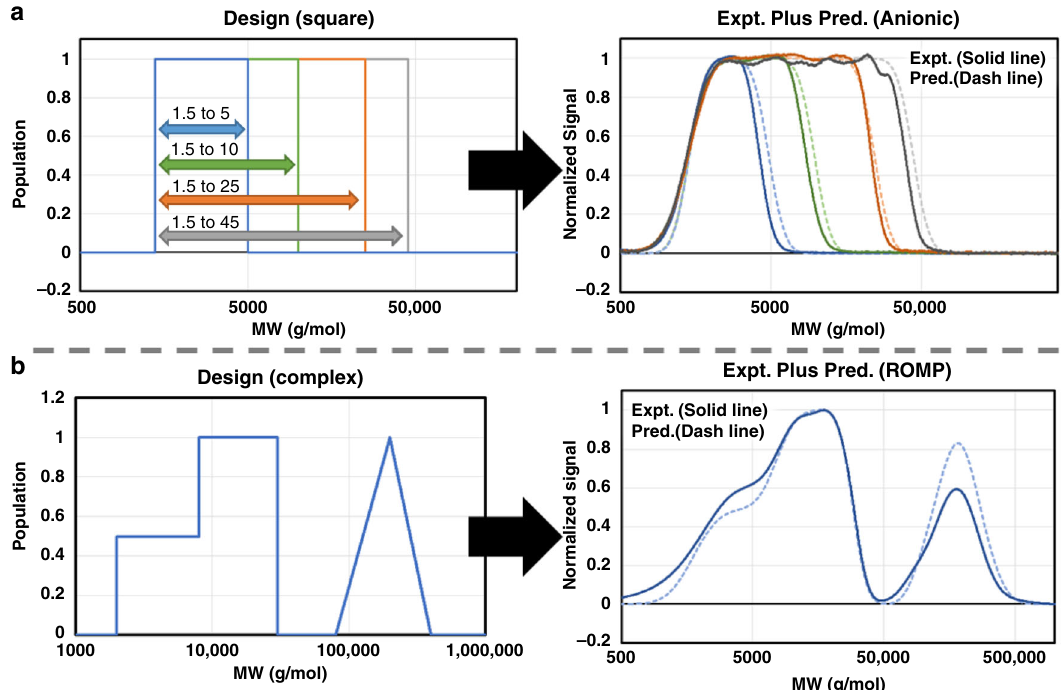
Fig. 7 Designs, experimental data, and predictions for targeted MWD. a (left) Design for the four targeted square MWDs. (right) GPC traces and predictions for the four square MWDs. b (left) Design for the targeted complex shape. (right) GPC trace and prediction for complex MWD.